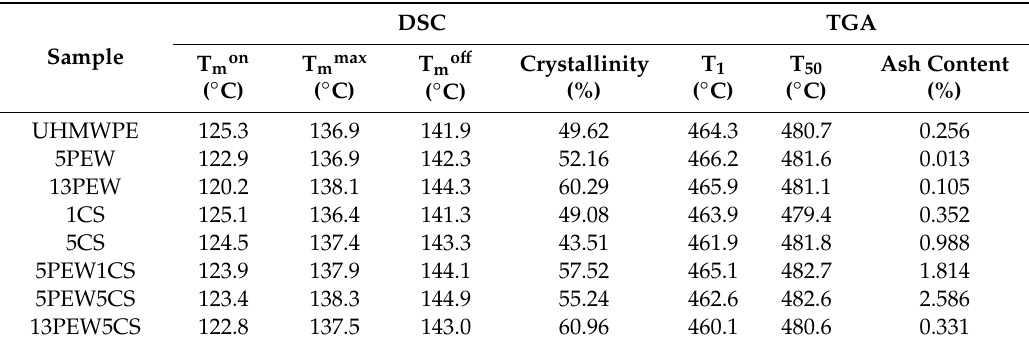
Figure 4. The Vicat softening temperature (VST) curves of UHMWPE with different contents of PEW and CS. 3.3. Thermomechanical Properties The DMA test is considered to be an effective method to measure the molecular weight between physically effective cross-linking points, including physical entanglement and chemical cross-linking [30]. The DMA curves of UHMWPE with different contents of PEW and CS are shown in Figure 5, and the platform modulus (E′), the average molecular weight between entanglement points (M e ), and the entanglement density (υ e ) are summarized in Table 3. The platform modulus, which is also known